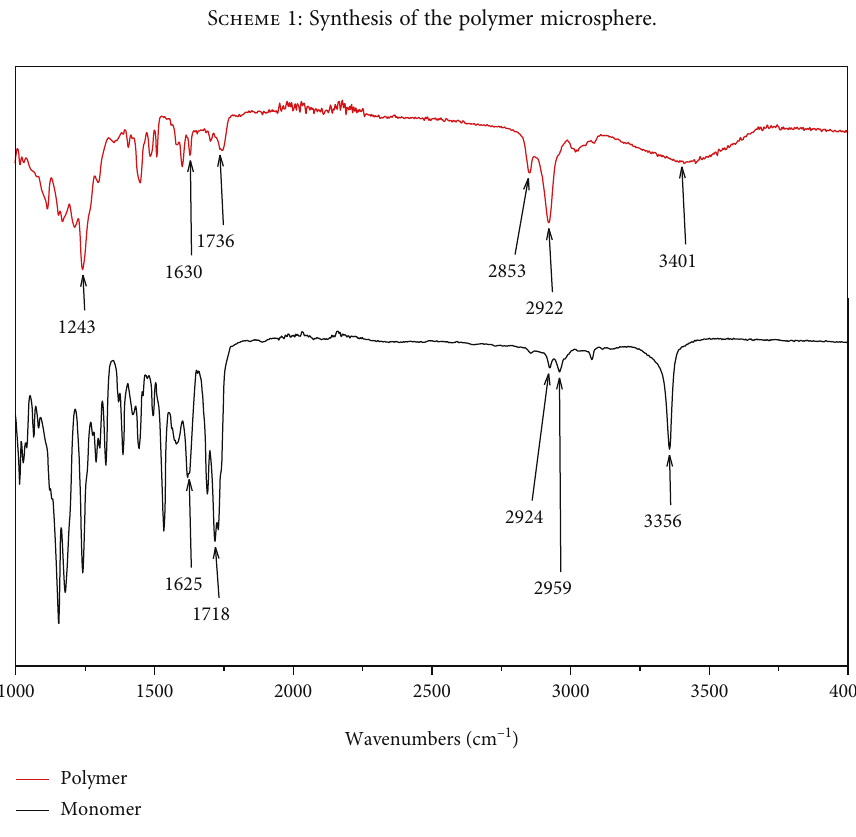
Figure 1: FTIR spectra of the umbelliferone derivative monomer and